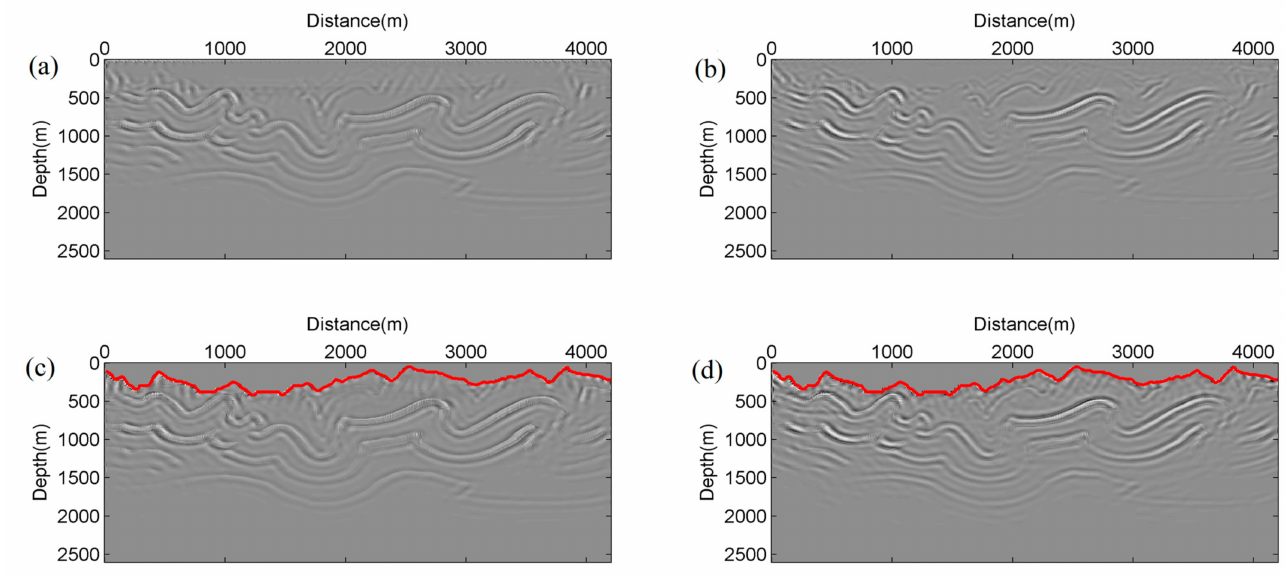
Figure 14. Migration images for modified Canadian Foothills elastic models with different topographies. The left panels are the PP-wave images, and the right panels are the PS-wave images. Panels ( a , b ) are the migration images for modified Canadian Foothills elastic model with a horizontal topography, and panels ( c , d ) are the migration images for modified Canadian Foothills elastic model with a surface topography. The red line is the surface topography.